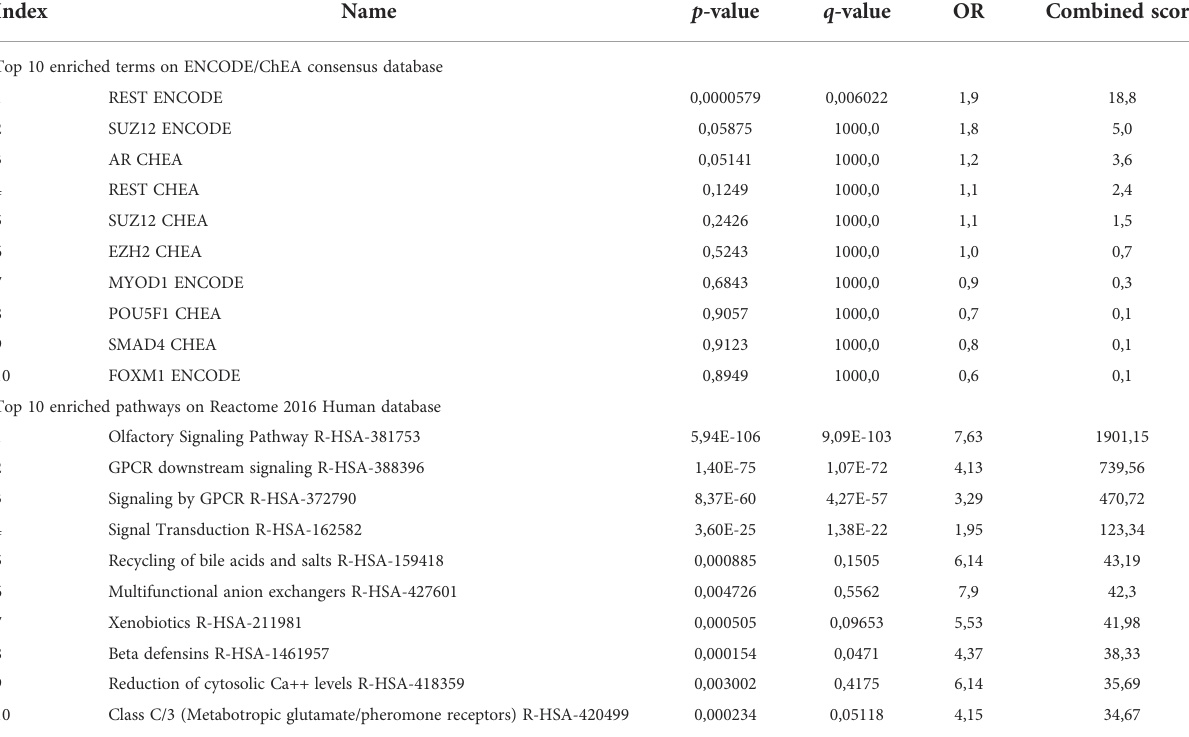
TABLE 6 Pathway analysis on EnrichR of downregulated